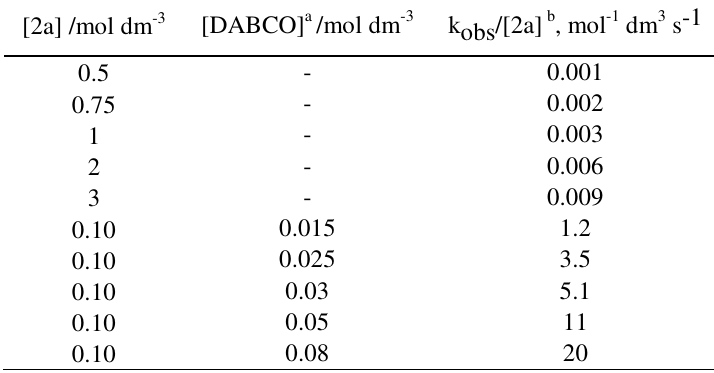
Table 1. Kinetic results for the reaction of 1 with 2,6-diethylaniline, 2a, in DMSO at 25 o C.